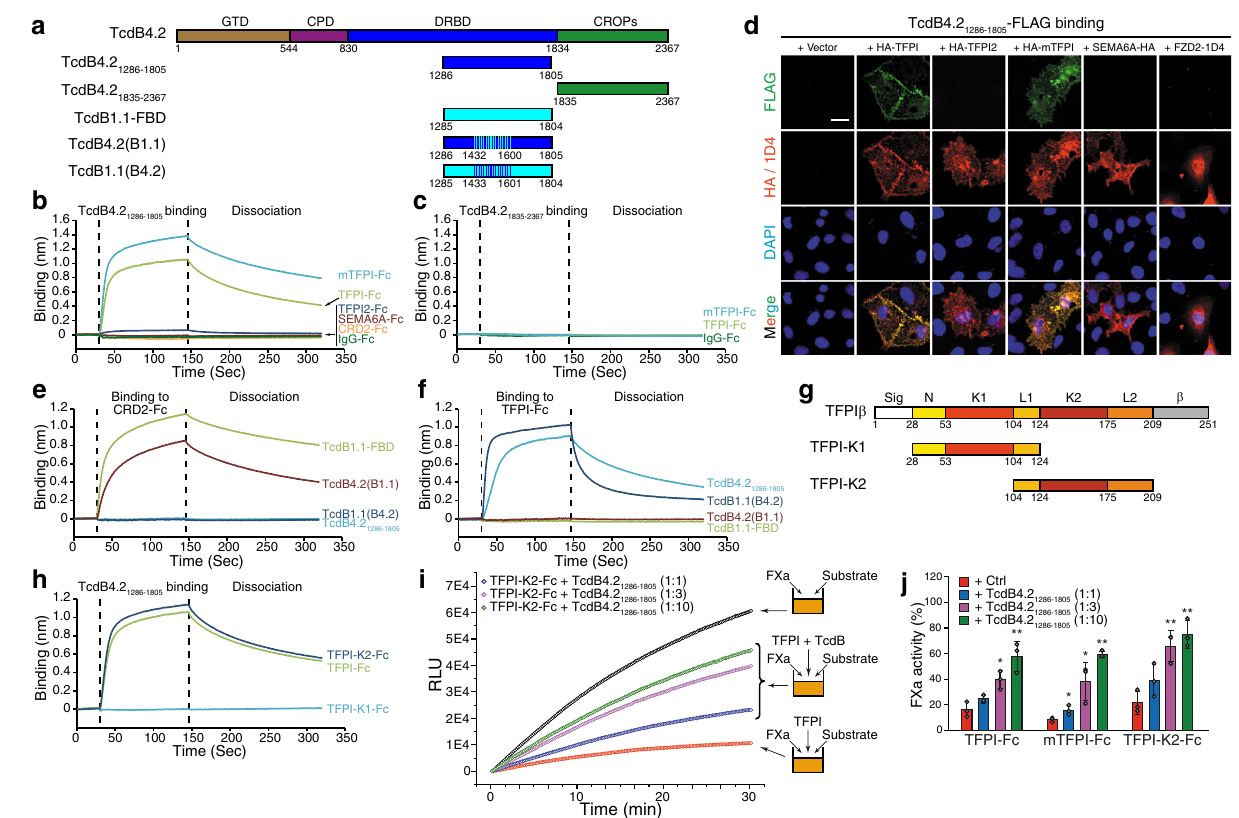
Fig. 3 | Characterizing TFPI-TcdB4 interactions. a Schematic diagrams of TcdB4.2, TcdB4.2 1286 – 1805 , TcdB4.2 1835 – 2367 , TcdB1.1-FBD. TcdB4.1(B1.1) and TcdB1.1(B4.2) represent two mutant fragments exchanging 29 residues in the region 1432 – 1600 that differ between TcdB4.1 and TcdB1.1. The numbers indicate the position of amino acid residues. GTD, glucosyltransferase domain; CPD, cysteine protease domain; DRBD, delivery/receptor-binding domain; CROPs, combined repetitive oligopeptides. Binding of 500nM TcdB4.2 1286 – 1805 ( b ) or TcdB4.2 1835 – 2367 ( c )toFc-taggedTFPIandmTFPIwasexaminedusingBLIassays.Fc- tagged TFPI2, CRD2, SEMA6A, and IgG were used as controls. Representative sen- sorgrams from one of three independent experiments are shown. d HeLa cells transientlytransfected withTFPI,TFPI2,mTFPI,SEMA6A,orFZD2wereexposedto FLAG-tagged TcdB4.2 1286 – 1805 (5 µ g/mL) on ice for 60min, washed, fi xed, permea- bilized, and subjected to immunostaining analysis. Expression of exogenous pro- teins was con fi rmed by detecting fused HA or 1D4 tag. Nuclei were labeled with DAPI (blue). Scale bar, 5 µ m. Representative images were from one of three inde- pendent experiments. Binding of 500nM TcdB1.1-FBD, TcdB4.2 1286 – 1805 , TcdB4.2(B1.1), and TcdB1.1(B4.2) to Fc-tagged CRD2 ( e ) and TFPI ( f ) was